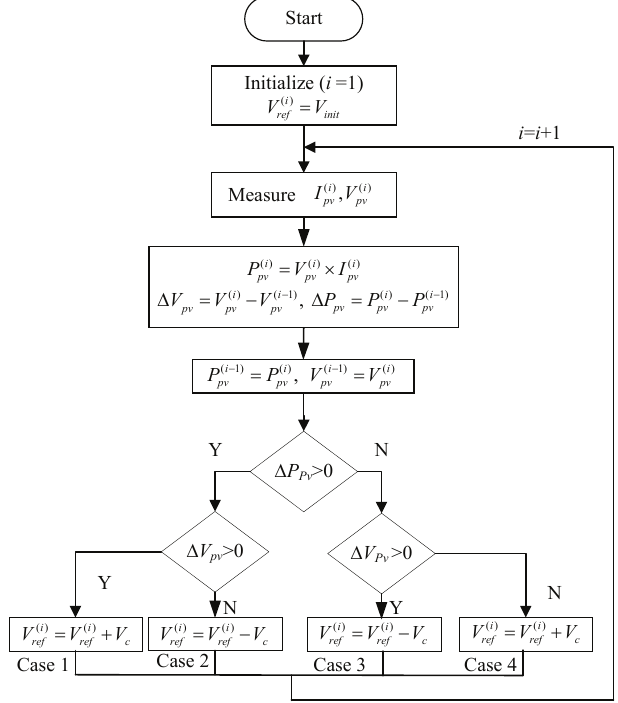
Figure 2. Flow chart of P & O